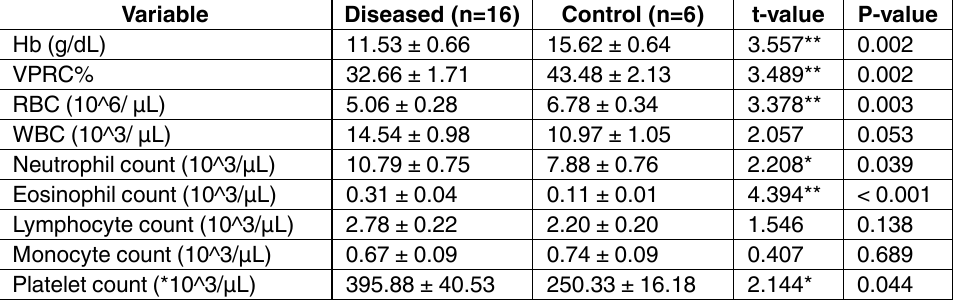
table 1. Haemogram, leucogram and platelet count of diseased and control animals